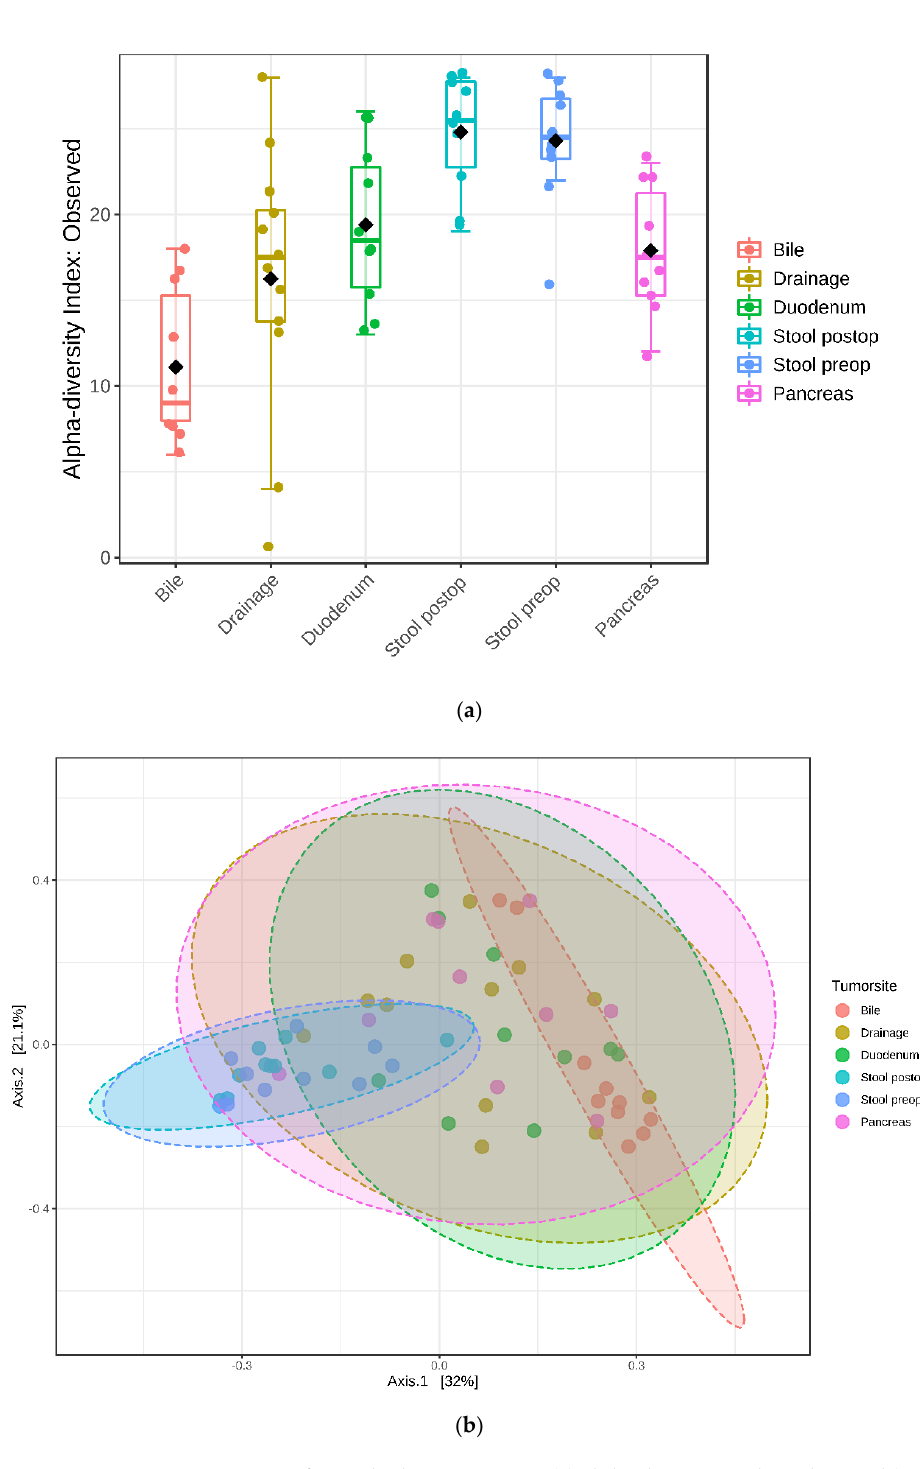
Figure 4. Diversity comparisons of microbial communities. ( a ) alpha diversity index: observed ( p -value: 4.9602 × 10 −7 ; [ANOVA] F-value: 10.29); ( b ) beta diversity PCoA Jensen – Shannon [PERMANOVA] F-value: 4.5694, p -value < 0.001.